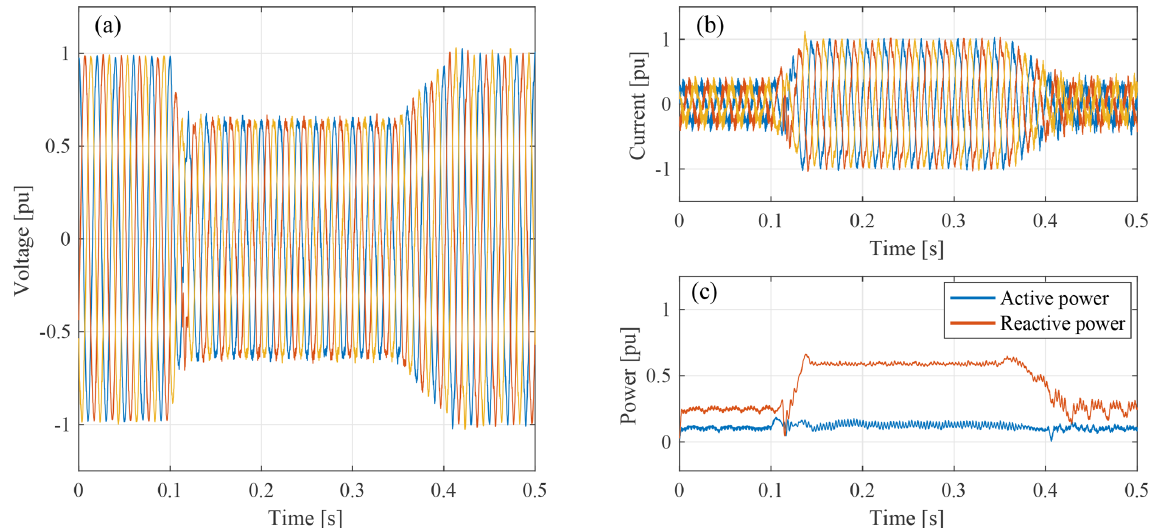
Figure 7. Wind turbine tested for LVRT at low power production: three-phase voltage (a) and current (b) , and active and reactive power output (c)